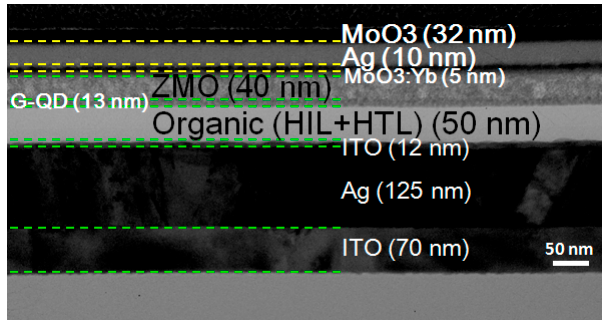
Figure 5. Cross-sectional transmission electron microscopy image of our green top-emission QLED with a DMD cathode.